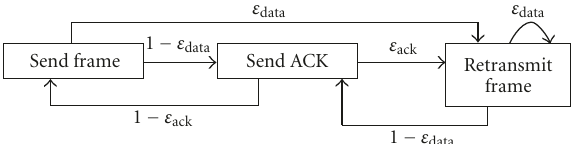
Figure 3: Markov model of Simple